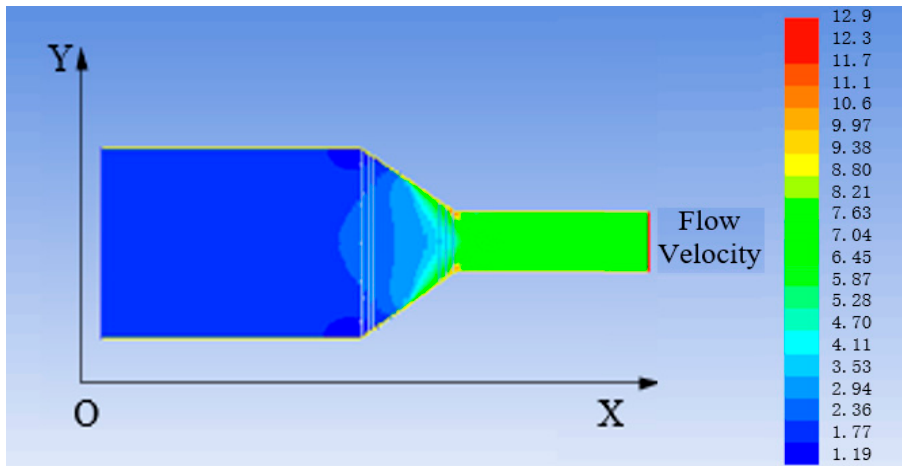
Figure 17. Strain of the venturi.